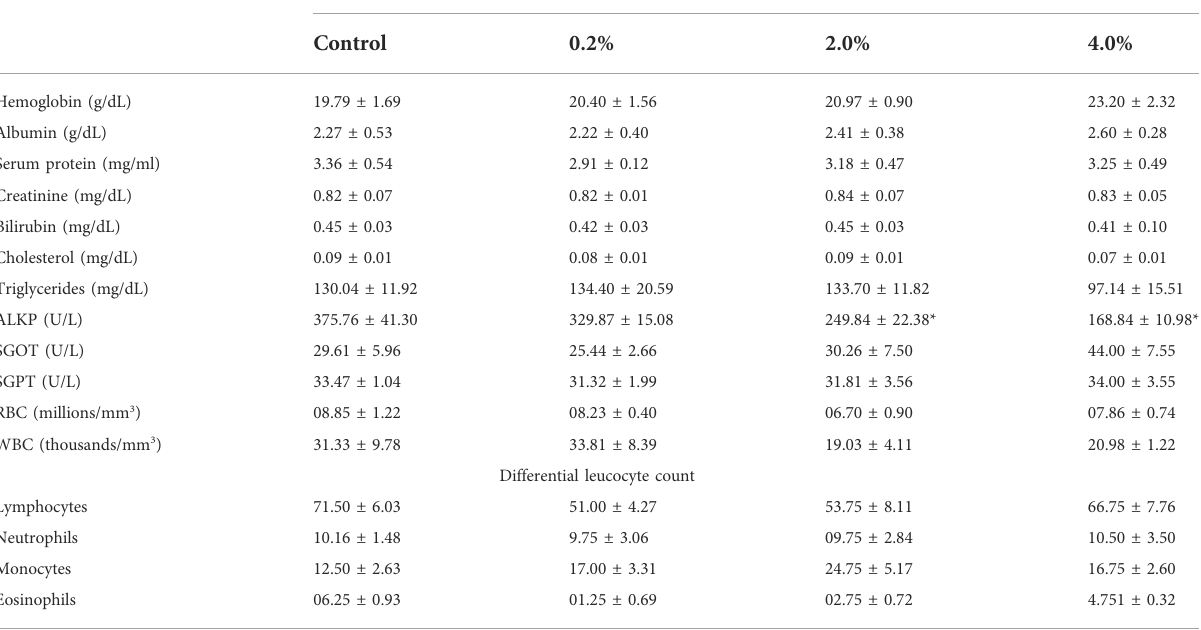
TABLE 6 Effect of LLA (1:1 w/w ratio) at 0.2%, 2%, and 4% PEG200 solutions on different biochemical and hematological parameters when applied topically in Wistar rats once-a-day for 28 days..